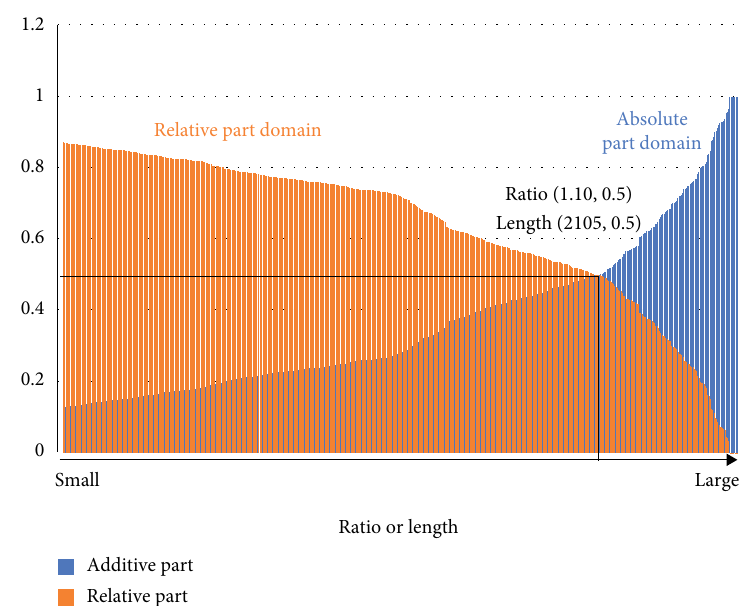
Figure 15: Relationship between the weight of latent class and ratio or